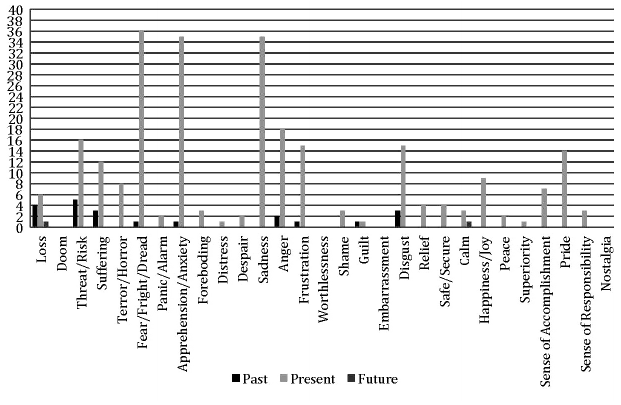
Fig. 5. Total emotion counts between 27 August 2001 and 29 May 2002.